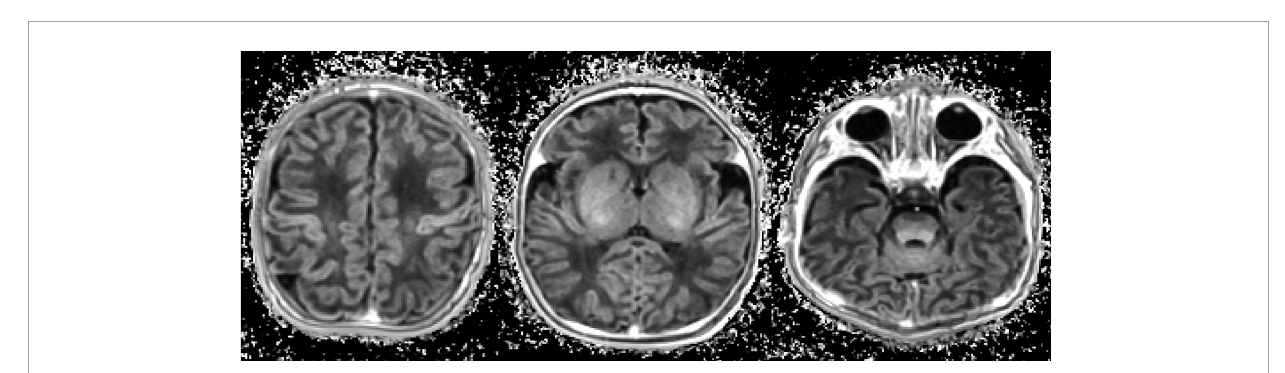
FIGURE3 Example of a T1w/T2w map in a neonate (10 days of